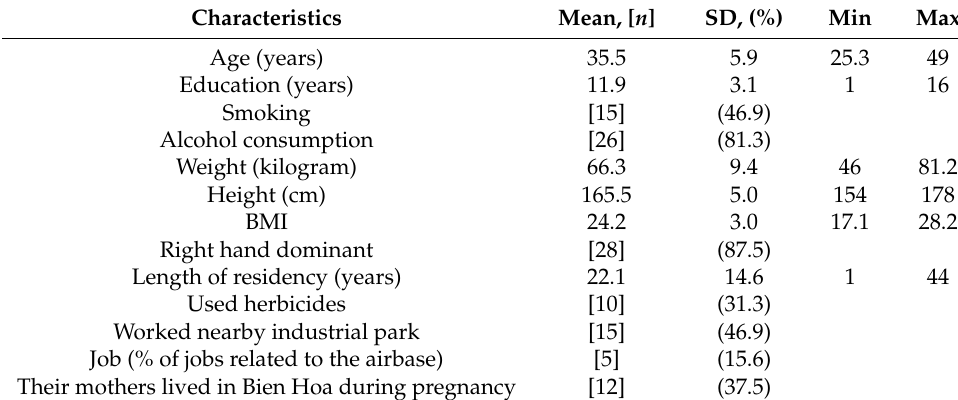
Table 2. Characteristics of the subjects ( n = 32).